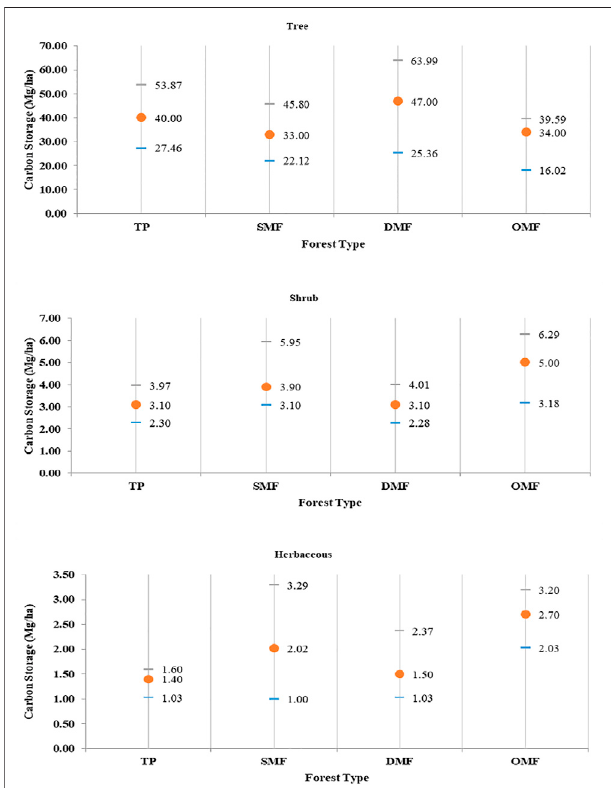
FIGURE 6 | Estimates of Carbon storage in tree/shrub/herb vegetation with 95% C.I. in dry tropical forest of AABR (Mg/ha).